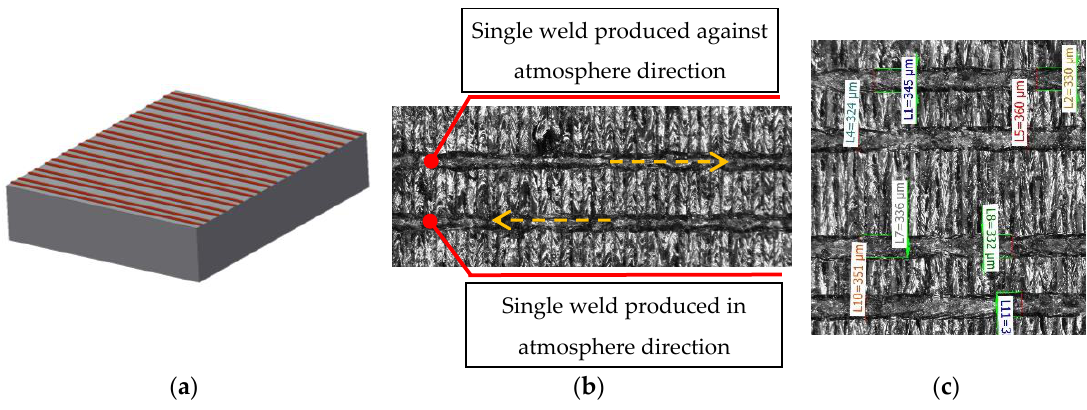
Figure 4. ( a ) Shape of the single welds samples; ( b ) one combination of process parameters produced in and against the atmosphere flow; ( c ) measurement of width of the single welds.